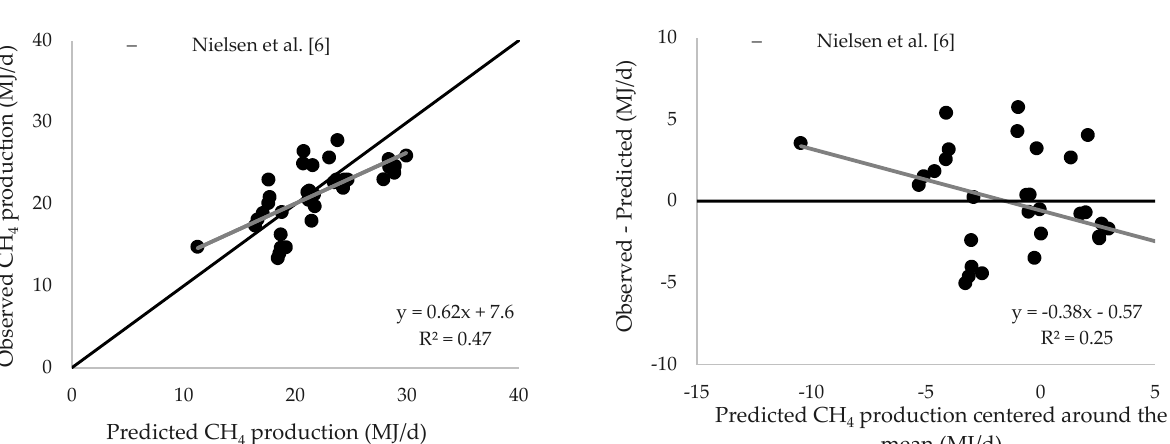
Figure 1. Observed versus predicted values of enteric CH 4 production and the residuals (observed minus predicted) for basic models used in Norway and the Model 3 developed in the present study. The graphs to the left show that the models overestimate CH 4 emissions at the lower range and underestimate emissions at the upper range. The graphs to the right show the presence of a linear bias (slope) and the presence of a mean bias (intercept).